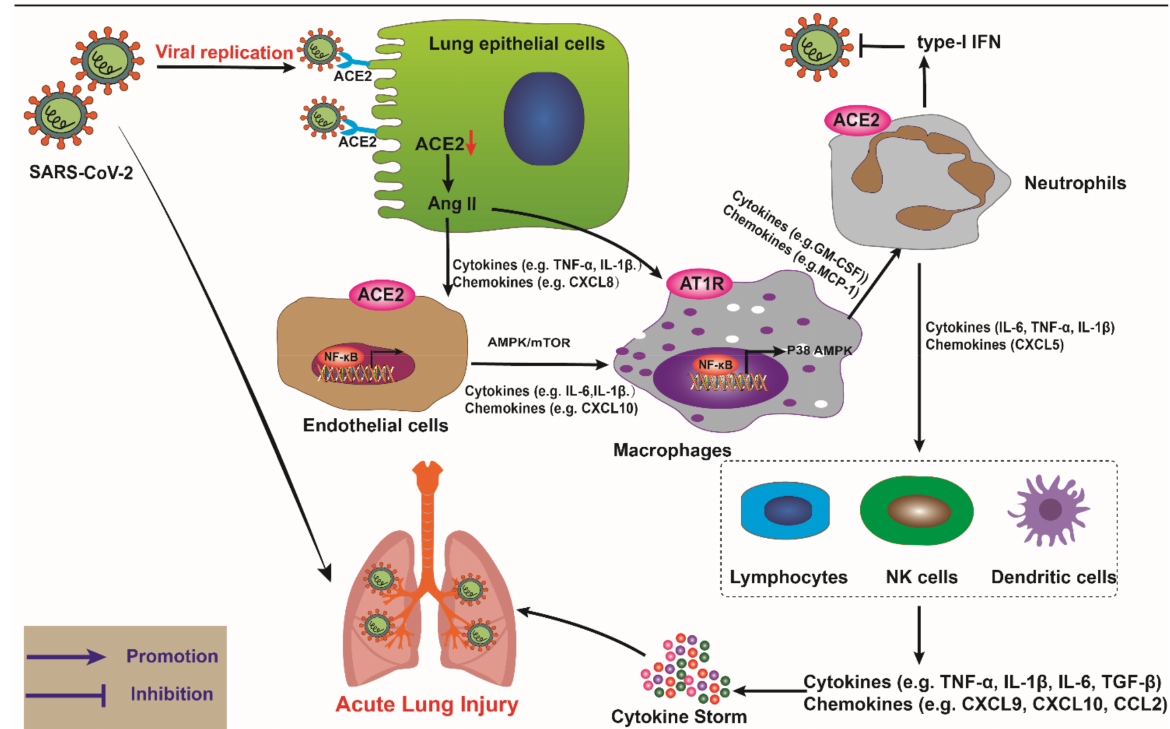
Figure 2. The cellular immune response of ALI induced by SARS-CoV2 infection. SARS-CoV-2 binds to ACE2 in type II alveolar cells after entering the respiratory tract, resulting in decreased ACE2 and increased Ang II. The association of Ang II with AT1R could induce bronchial smooth muscle contraction, pulmonary vascular hyperpermeability, alveolar epithelial release of numerous inflammatory cytokines, and chemokines. Alveolar macrophages could relieve lung tissue injury and inflammation through adenosine monophosphate-activated protein kinase (AMPK) and mammalian target of rapamycin (mTOR) pathways. Numerous cytokines and chemokines activate neutrophils to produce type-I IFN, inhibit virus infection, and neutrophils release numerous inflammatory factors and chemokines, promote the maturation of natural killer cells (NKs), dendritic cells (DCs), and the activation and migration of lymphocytes, activate the adaptive immune system, leading to further expansion of the immune response, and ultimately triggering a cytokine storm. The red arrow indicates a